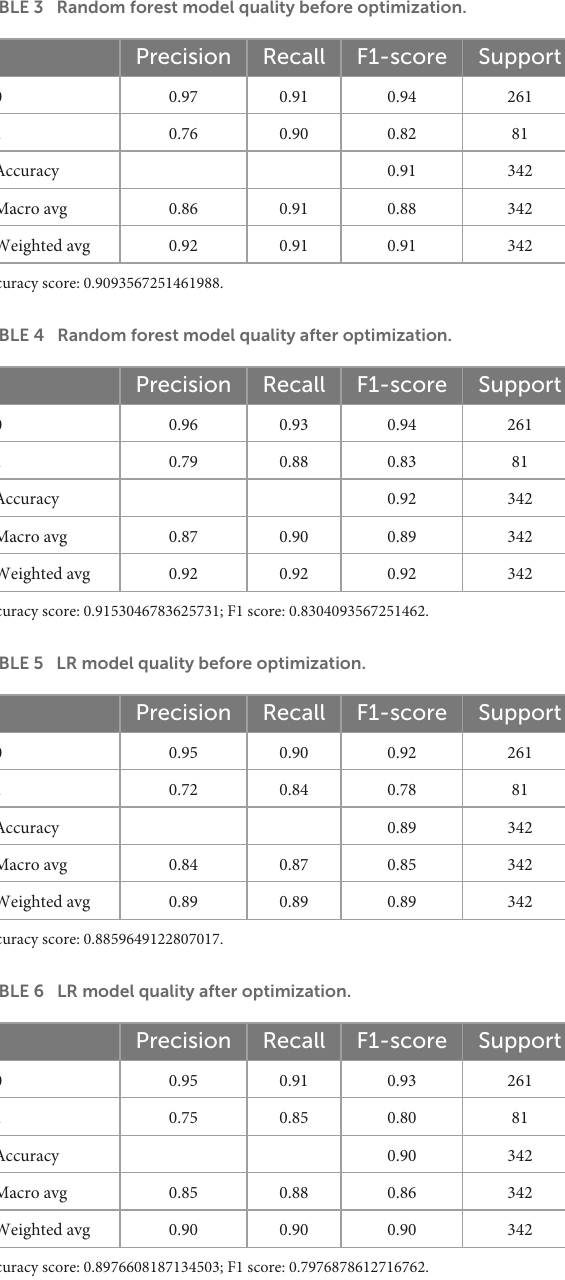
TABLE 3 Random forest model quality before optimization.